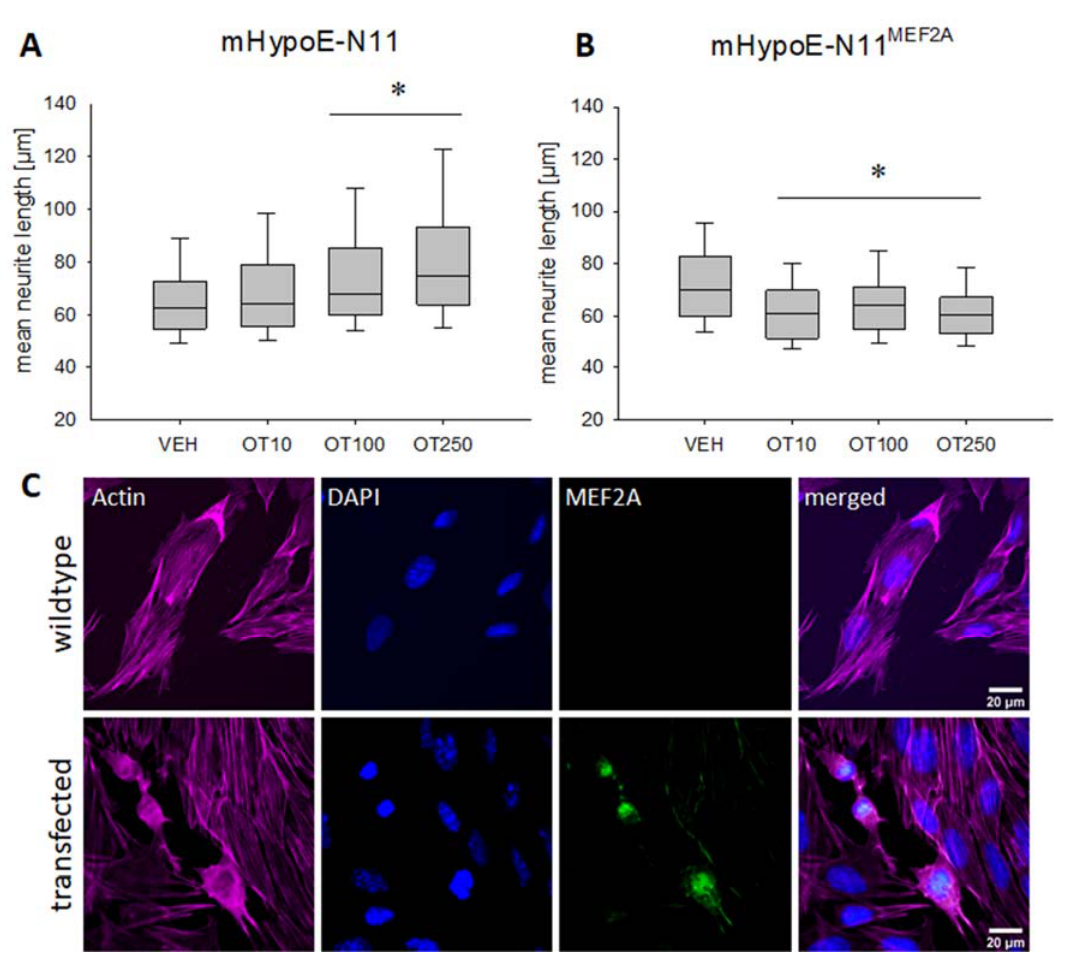
Figure 1. Effects of oxytocin (OT) on neuronal morphology in the mouse hypothalamic cell line mHypoE-N11. ( A ) Median neurite length increases significantly in wild-type mHypoE-N11 cells treated overnight with 100 or 250 nM OT. n = 100 cells per treatment; * p < 0.012 vs. VEH. ( B ) Treatment with 10, 100 and 250 nM of OT induces a significant neurite retraction in MEF2A overexpressing mHypoE-N11 cells. n = 100 cells per treatment; * p < 0.003 vs. VEH. ( C ) Representative images of immunofluorescence labelling for MEF2A. Images were sequentially recorded for F-actin (Phalloidin, red, first column), chromatin (DAPI, blue, second column), and MEF2A (green, third column). Merged images are shown for each row in the fourth column. Labels left to the columns indicate the respective cell type (wild-type vs. transfected).